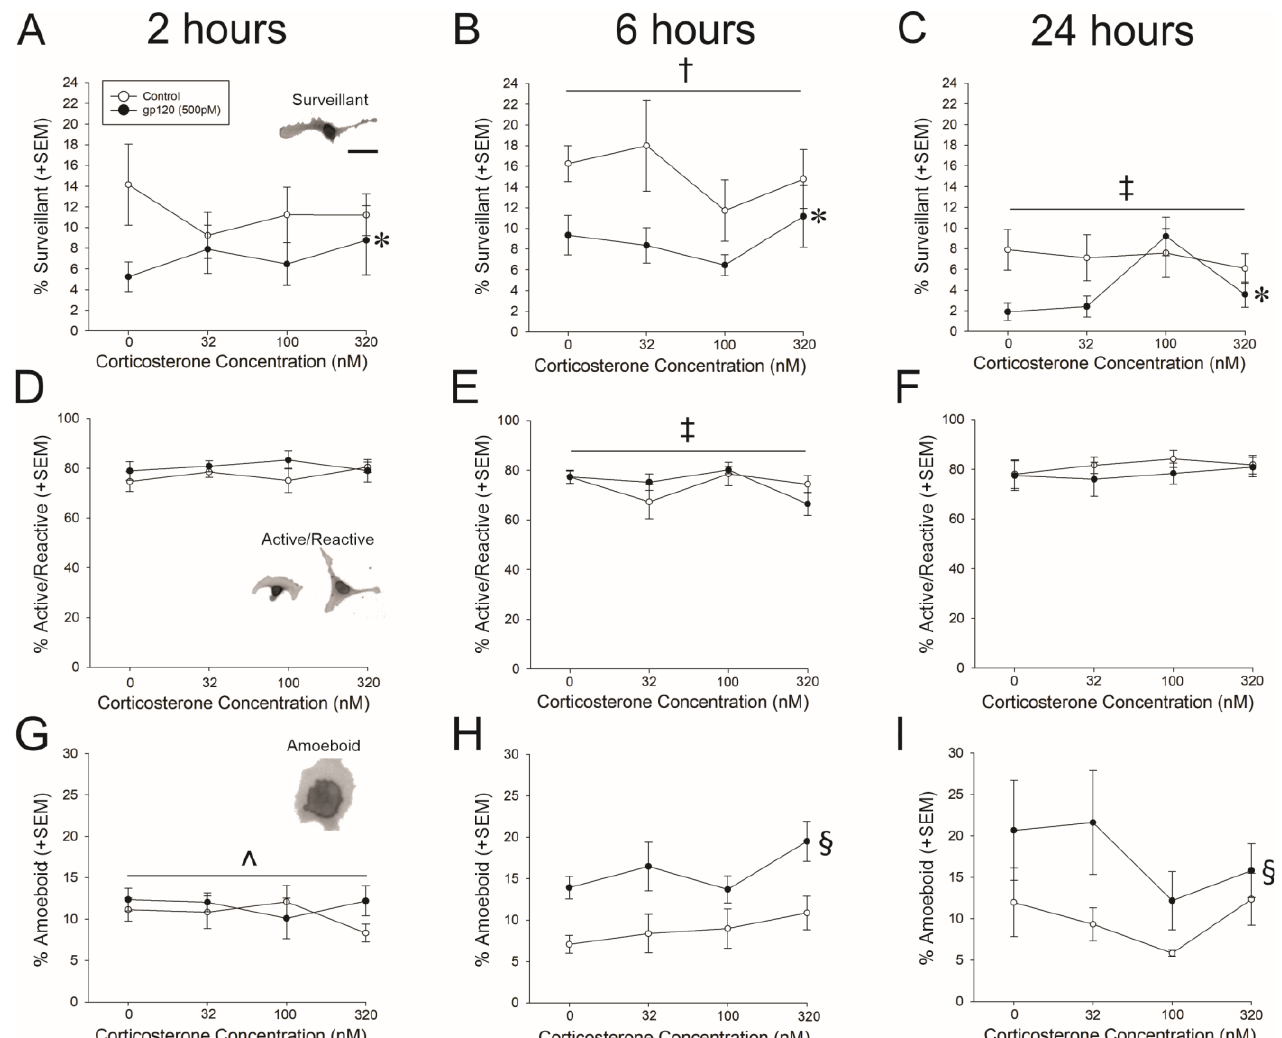
Figure 1. The proportion of surveillant microglia at 2 h ( A ), 6 h ( B ) and 24 h post-treatment ( C ). The proportion of active/reactive microglia at 2 h ( D ), 6 h ( E ) and 24 h post-treatment ( F ). The proportion of amoeboid/phagocytic microglia at 2 h ( G ), 6 h ( H ) and 24 h post-treatment ( I ). Figure ( A , D , G ) contain inset representative images of a surveillant, active/reactive, and amoeboid microglia, respectively (scale bare in A = 20 µm). † main effect of incubation time wherein 6 h significantly differs from 2 h; ‡ main effect time wherein the indicated time significantly differs from all other time-points; * main effect for gp120 to significantly differ from media control; § time × gp120 interaction wherein gp120 significantly differs from media control at 6 and 24 h only; ^ main effect of incubation time wherein the indicated time point is significantly different from all other time points; p <